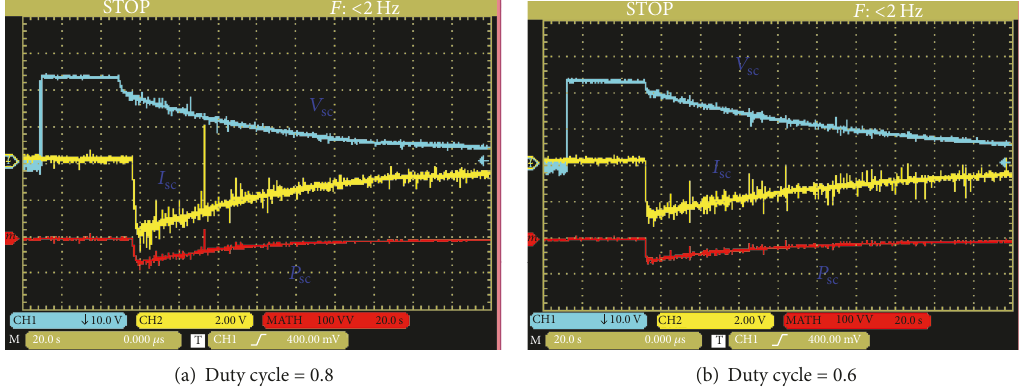
Figure 14: Voltage, current, and power waveforms of the ultracapacitors (discharging mode: